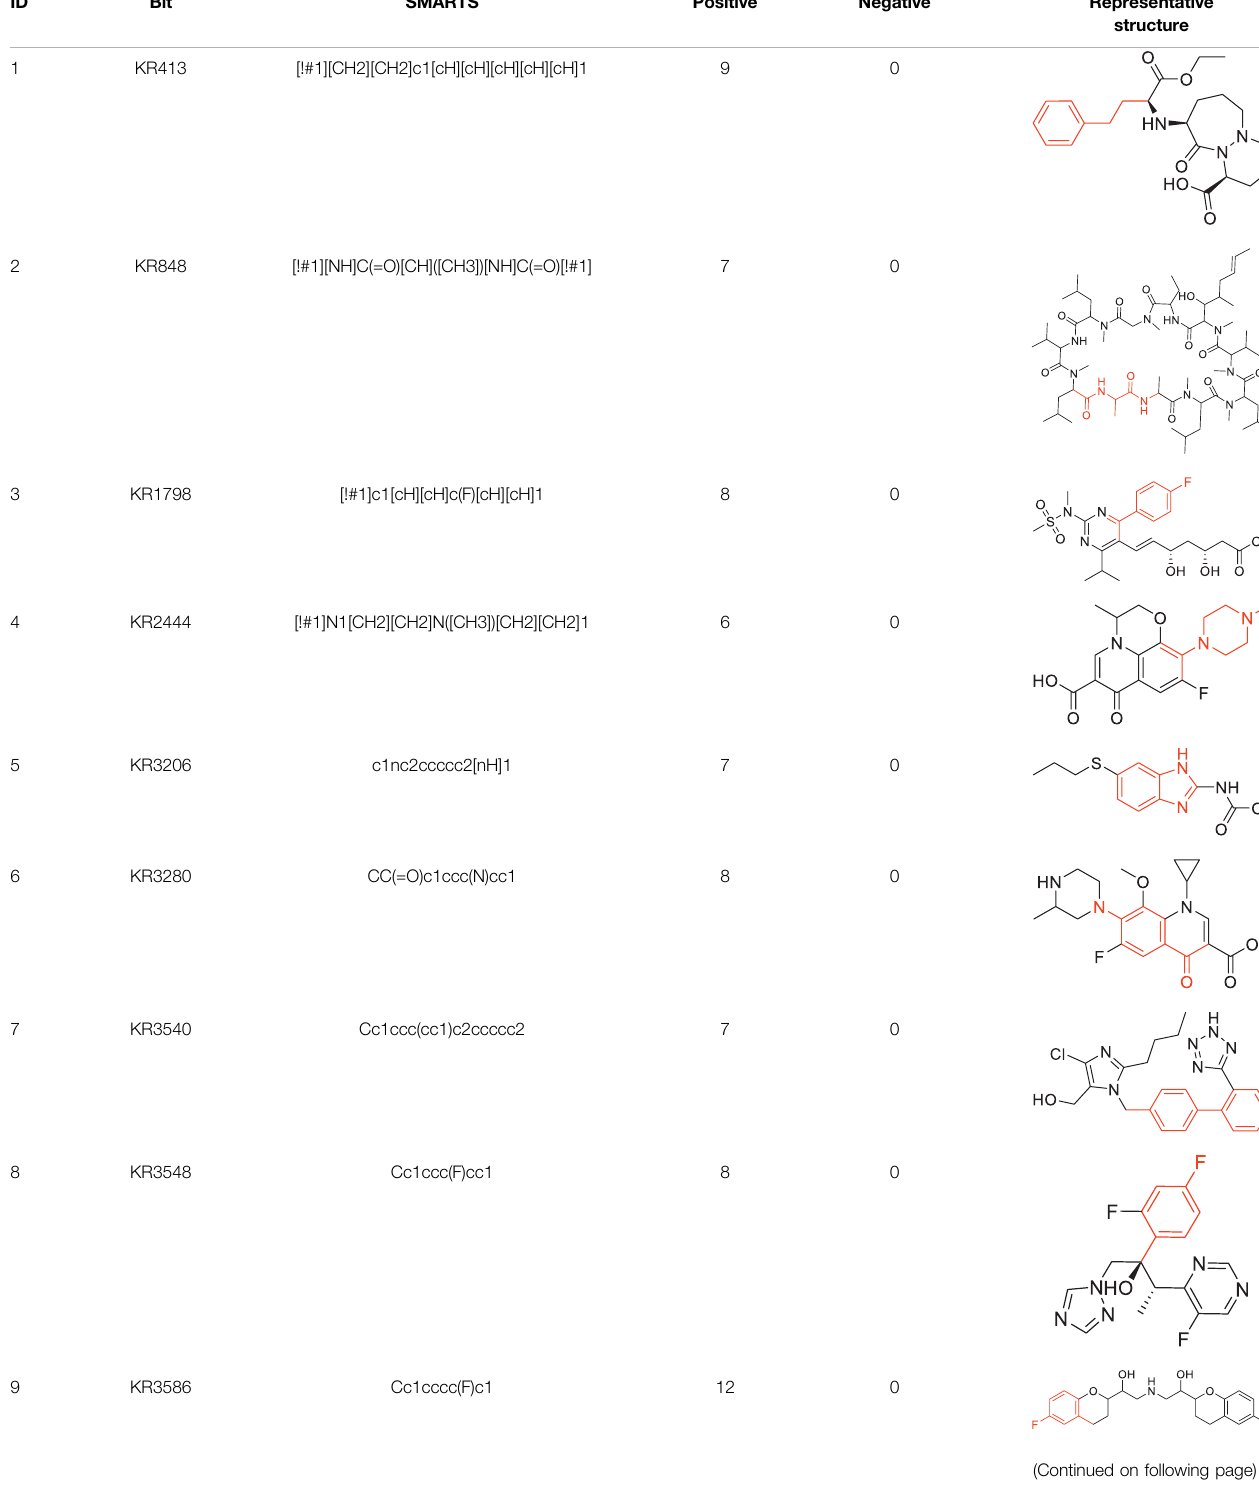
TABLE 4 | Structural alerts only presented in nephrotoxic